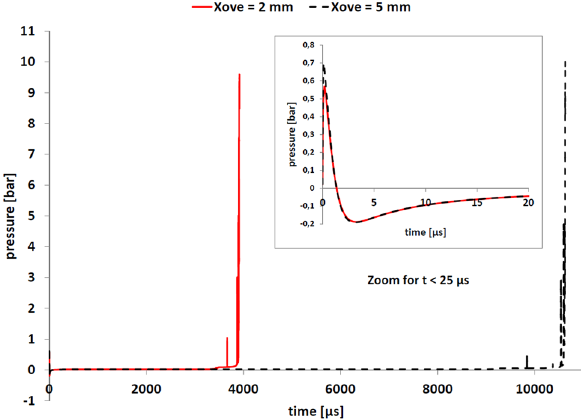
Fig. 7 Evolution of the minimum pressure in the chamber accord- Fig. 5 Time evolution of the chamber pressure for H = 12 µm, gap ing to X for different values of the Reynolds number (rotation ove Ω = 700 rpm, p = 10 bar and X = 2 and 5 mm ( Re = 63.8 , pump ove speed Ω indicated in parenthesis), H We = 0.06 and 𝜎 = 6622.91 )